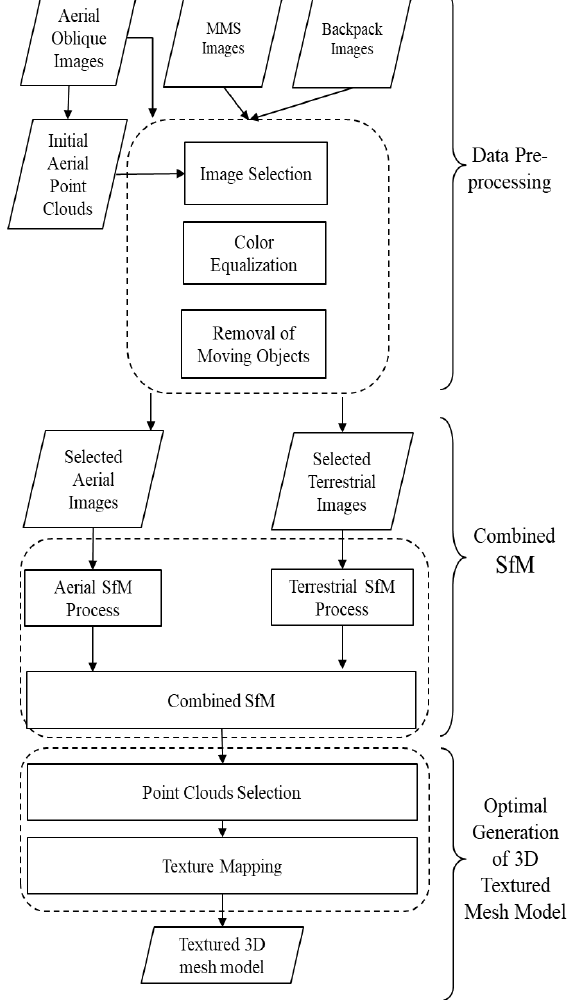
Figure 1. Overview of the proposed